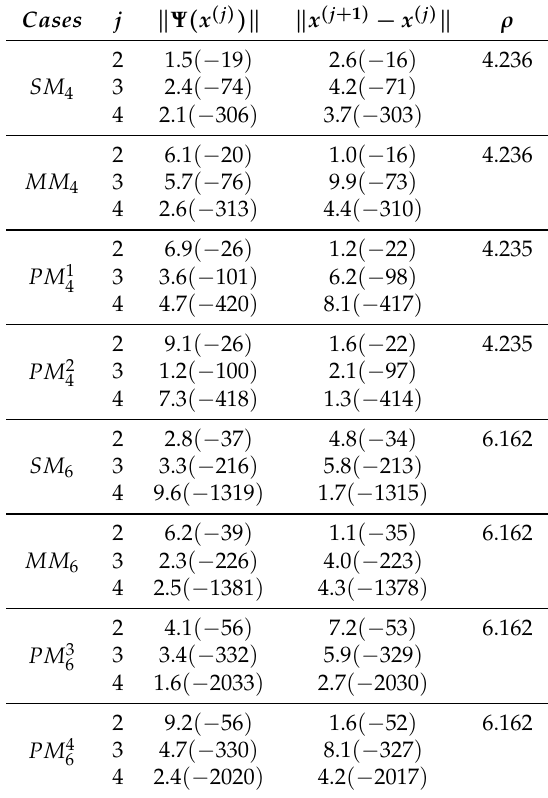
Table 6. Comparative study of different methods for Example 5.